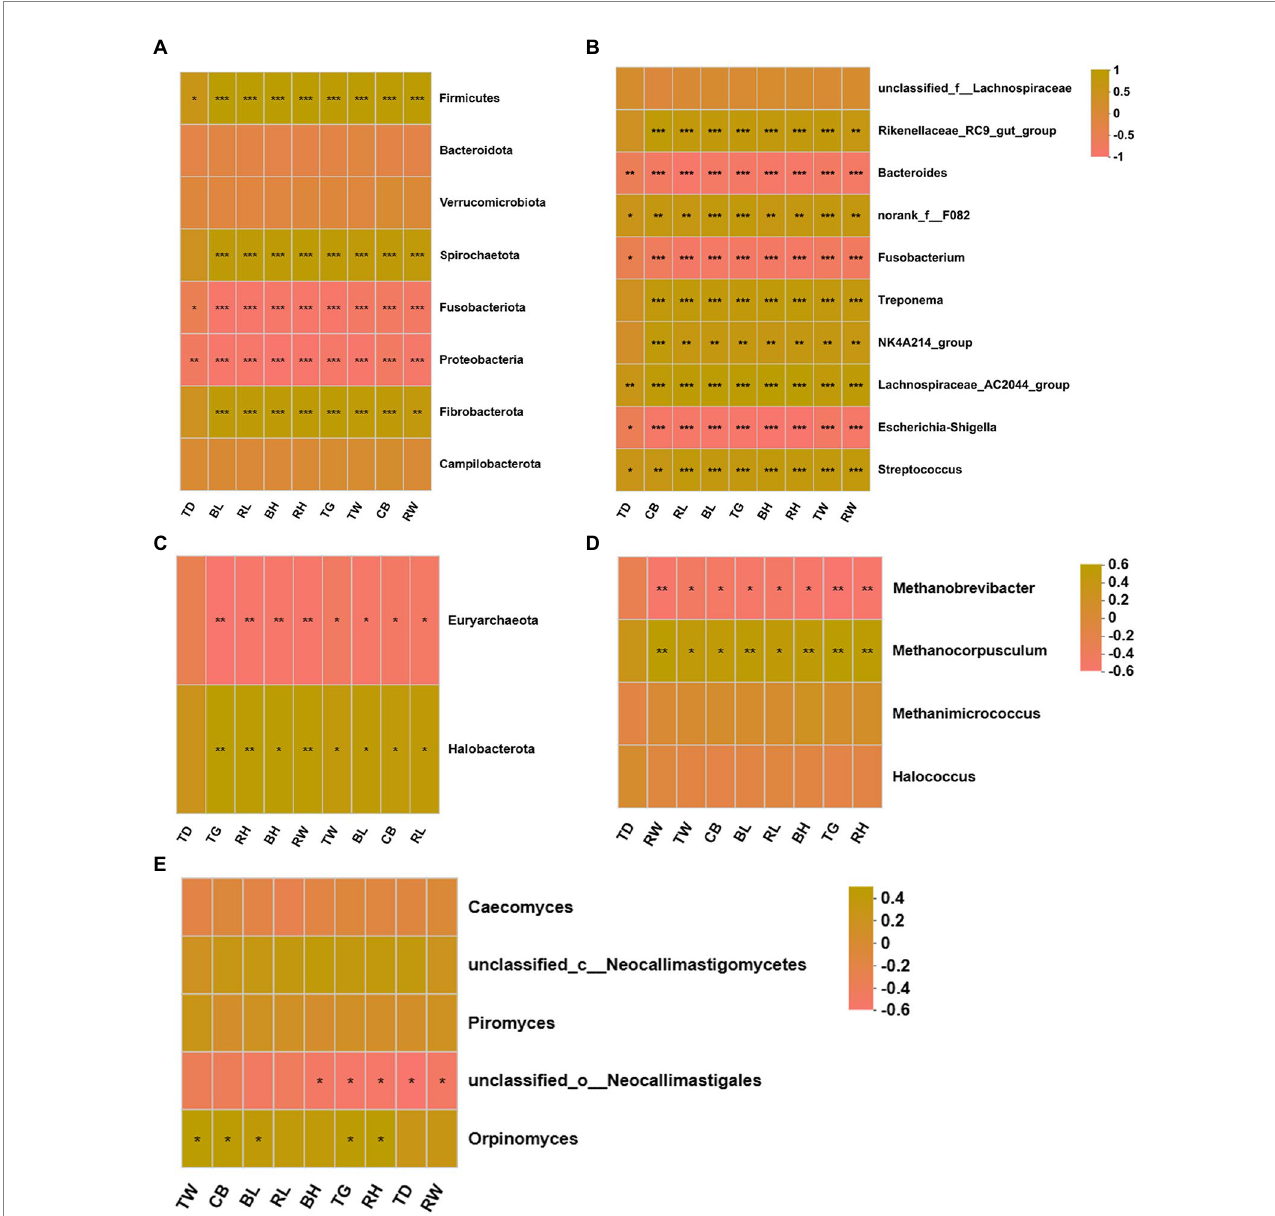
FIGURE 8 Correlation heatmap of differentially donkey fecal microbiota and body measurements. Each row in the graph represents a microbiota phylum/genus, each column represents a body measurement, the color in the graph indicates the Pearson coefficient between the microbial phylum/genus and donkey body measurements, and the brick yellow indicates positive correlation. The pale pink is representative negative correlation. The darker color indicate the greater the correlation. (A) Between donkey body measurements and bacteria at phylum level. (B) Between donkey body measurements and bacteria at genus level. (C) Between donkey body measurements and anaerobic fungi at phylum level. (D) Between donkey body measurements and anaerobic fungi at genus level. (E) Between donkey body measurements and archaea at genus level. * p < 0.05; ** p <0.01; *** p <0.001. BH, body height; BL, body length; TG, thoracic girth; TD, thoracic depth; TW, thoracic width; RH, rump height; RL, rump length; RW, rump width; CB, circumference of cannon